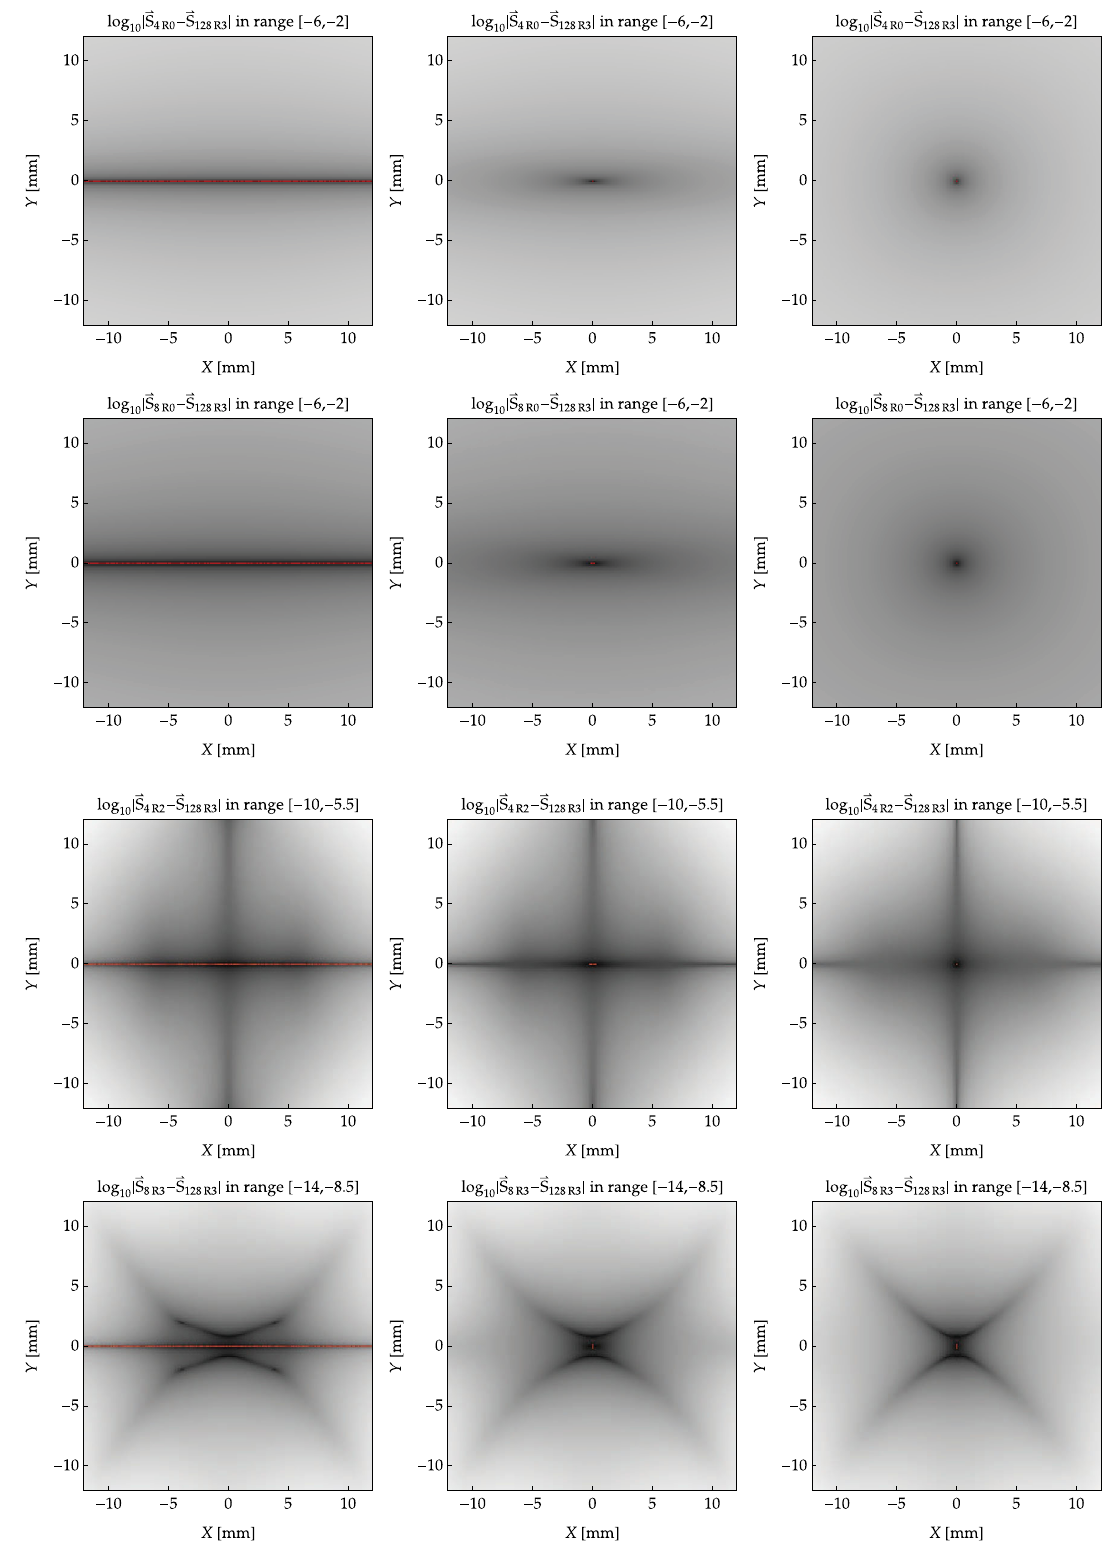
FIG. 12. Absolute error in the computed spin across a RHIC IR quadrupole. The rows, from top to bottom, show results obtained using four slices, eight slices, four slices plus two Romberg steps, and eight slices plus three Romberg steps. The columns, from left to right, show results averaged over spins covering an opening angle about the vertical of 0°, 20°, and